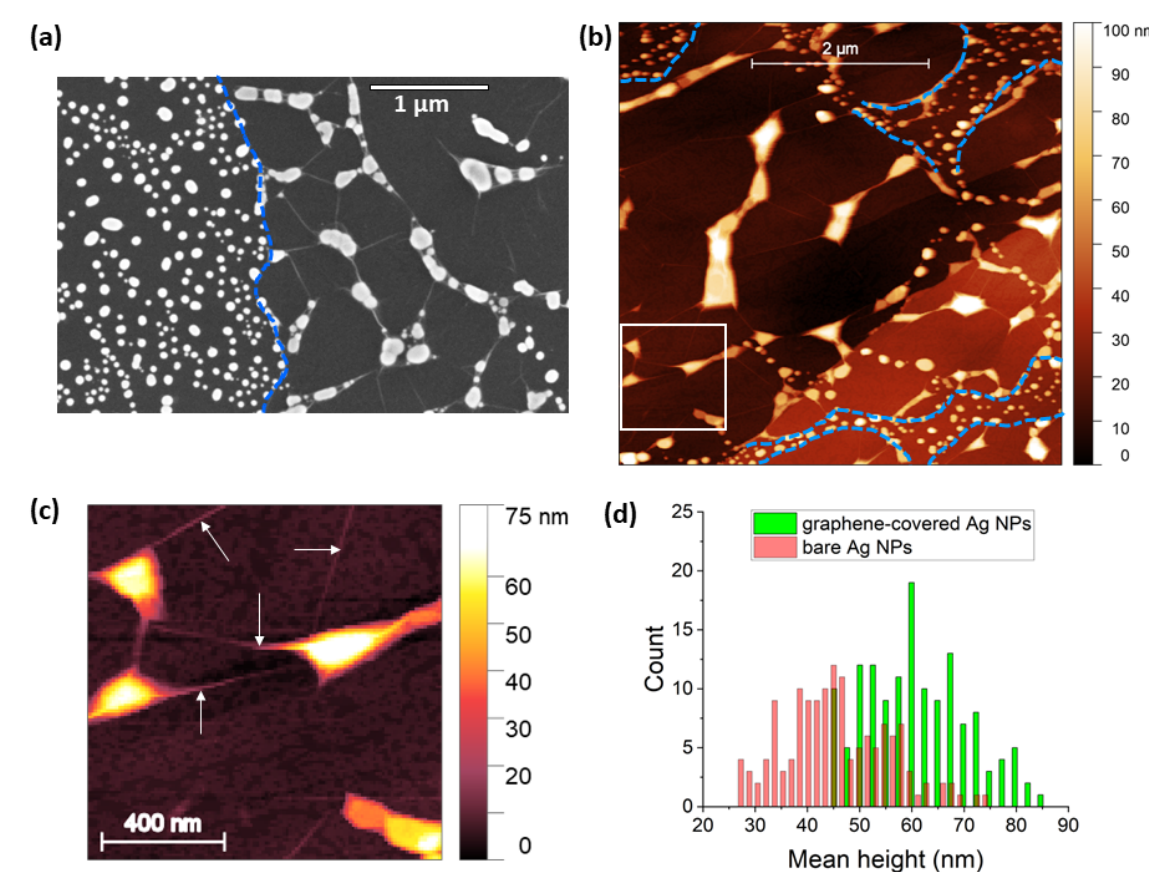
Figure 1. ( a ) SEM image of bare Ag NPs (left) and Ag NPs covered with graphene (right). The edge of graphene is marked with a blue dashed line as a guide for the eye. ( b ) AFM image of graphene- encapsulated Ag NPs. Discontinuities in the graphene overlayer and areas with bare Ag NPs are demarcated with blue dashed lines. Several graphene-covered nanoparticles are demarcated with a white square and shown in the enlarged image in ( c ). Here, wrinkling of the graphene overlayer is observed (arrows). ( d ) The mean height distribution of graphene-covered (green) and bare Ag NPs (red) was measured on 142 NPs in both cases.